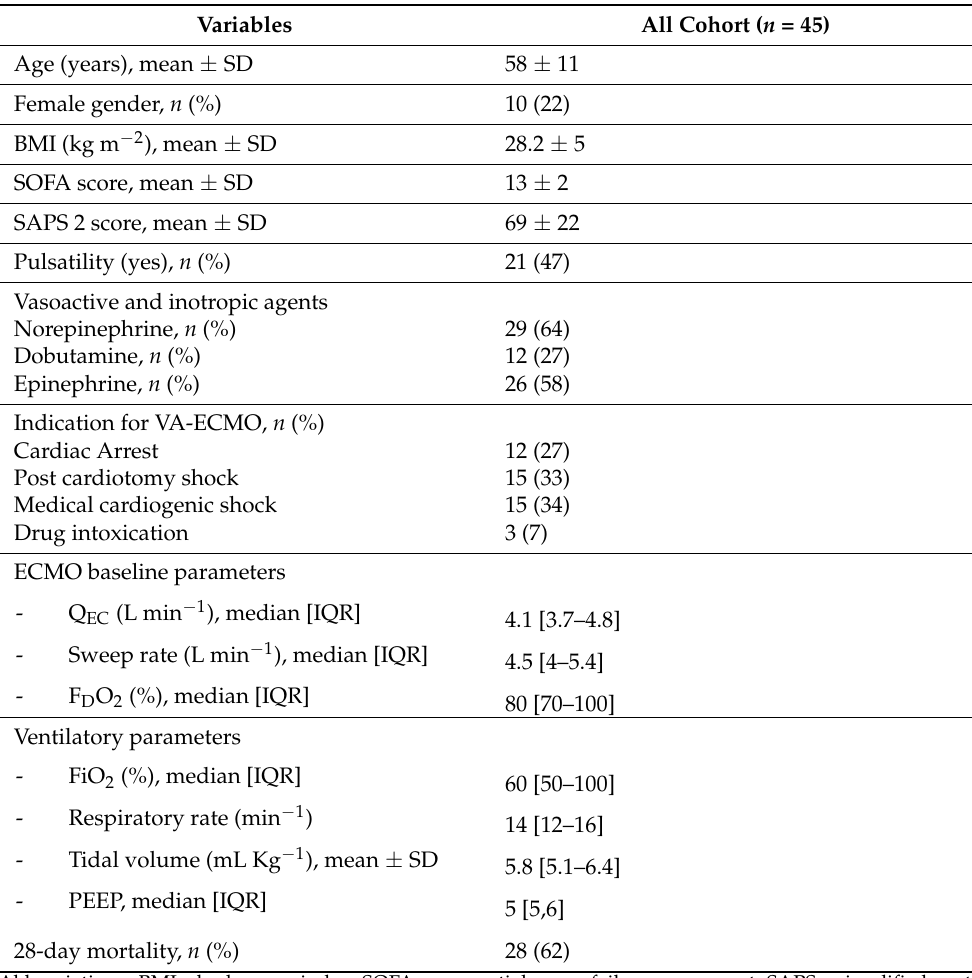
Table 1. Patients’ demographic and hemodynamic characteristics at baseline.